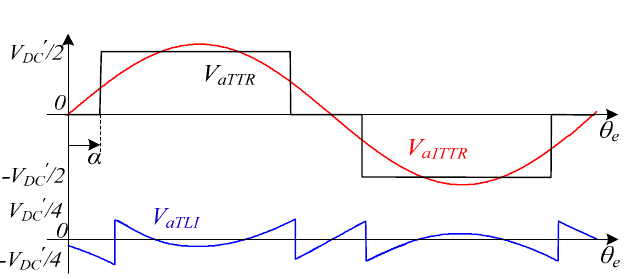
Figure 7. Two-level inverter (TLI) reference voltage for active power filtering.